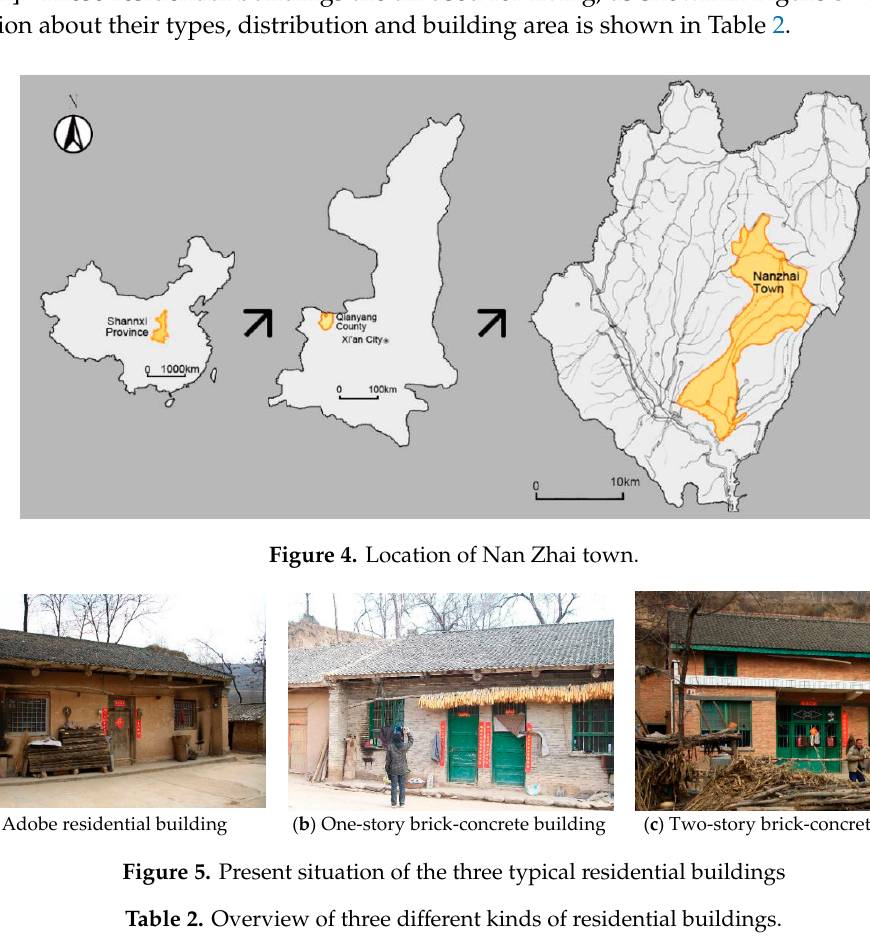
Figure 5. Present situation of the three typical residential buildings Table 2. Overview of three di ff erent kinds of residential